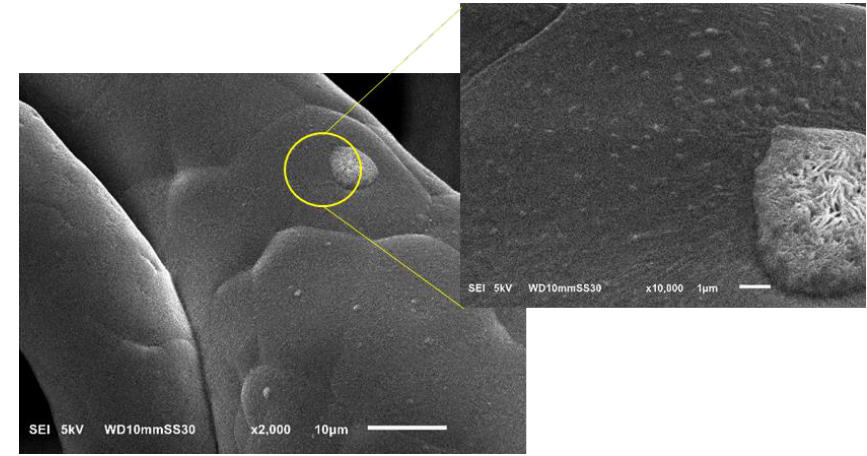
Figure 18. Scanning electron micrographs of PBS melt-electrospun microfibers containing 3% silver nanoparticles (S3). The inset image shows the silver particles homogeneously distributed on the fiber.